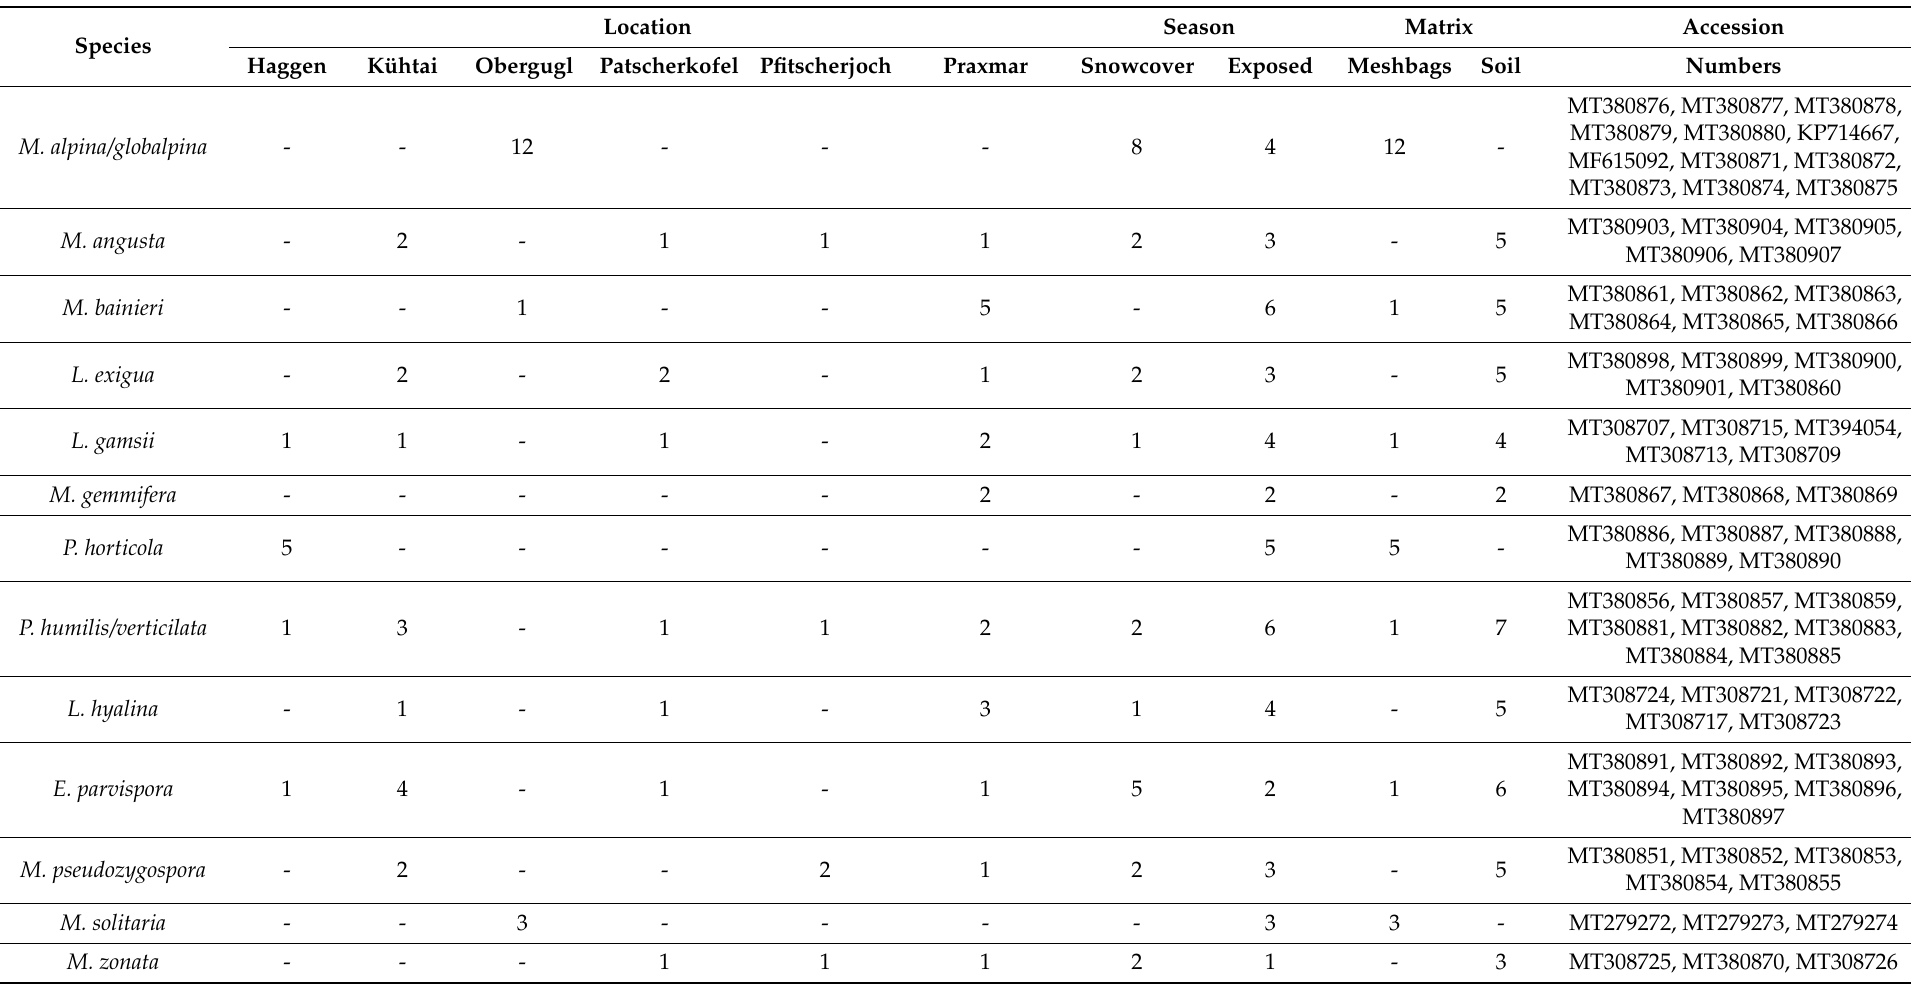
Table 1. Origin of the analyzed pure culture isolates ( n = 72) belonging to 13 different species of Mortierella s. l. (including Entomortierella , Linnemannia , Mortierella s. s. , and Podila ) in alphabetical order based on species epithet. Information on sampling locations and conditions are provided; Season: snow-covered soil or soil during the vegetation period (=exposed); Matrix: isolated from buried mesh-bags filled with sterile quartz sand or directly from the